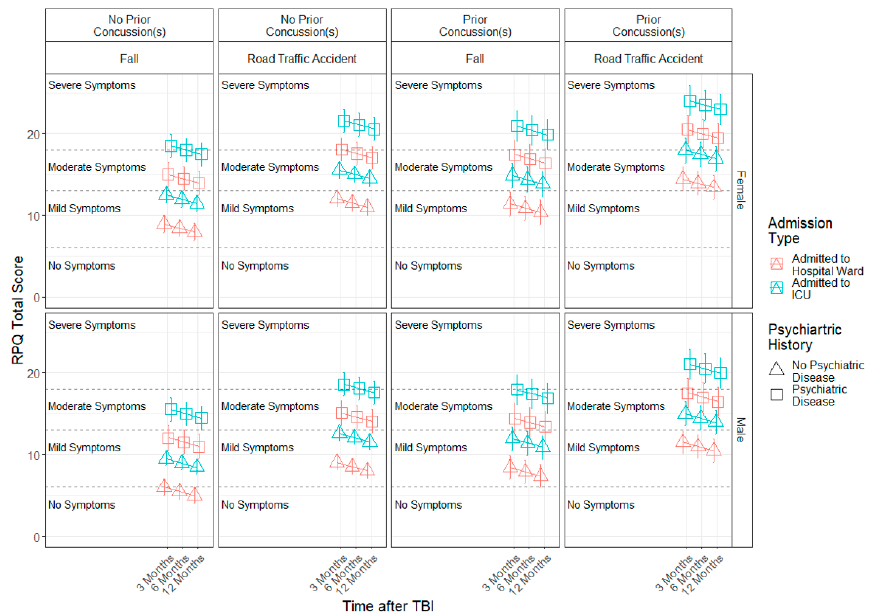
Figure 5. Modelled trajectories for the RPQ total score by significant predictors.